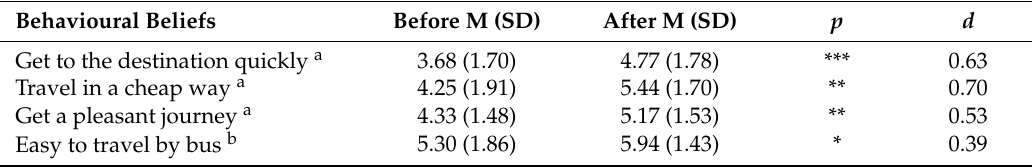
Table 9. Beliefs before and after. Mean, SDs and Cohen’s